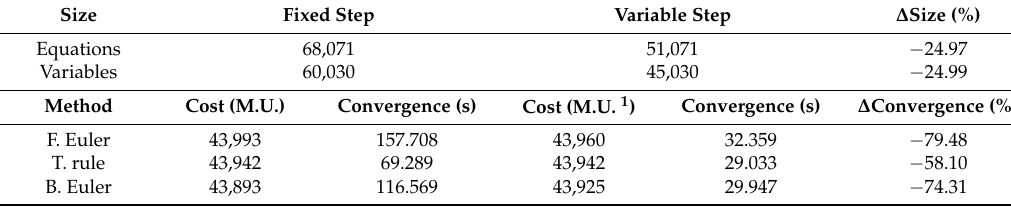
Table 4. Results of TSCOPF considering fixed and variable integration time step.